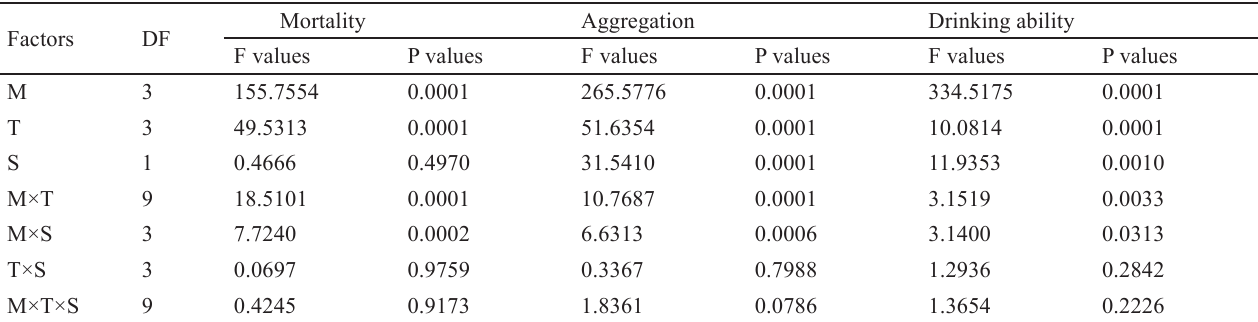
Table 1 . ANOVA for the main factors of the fumigation test affecting the behaviors of red imported fire ant.